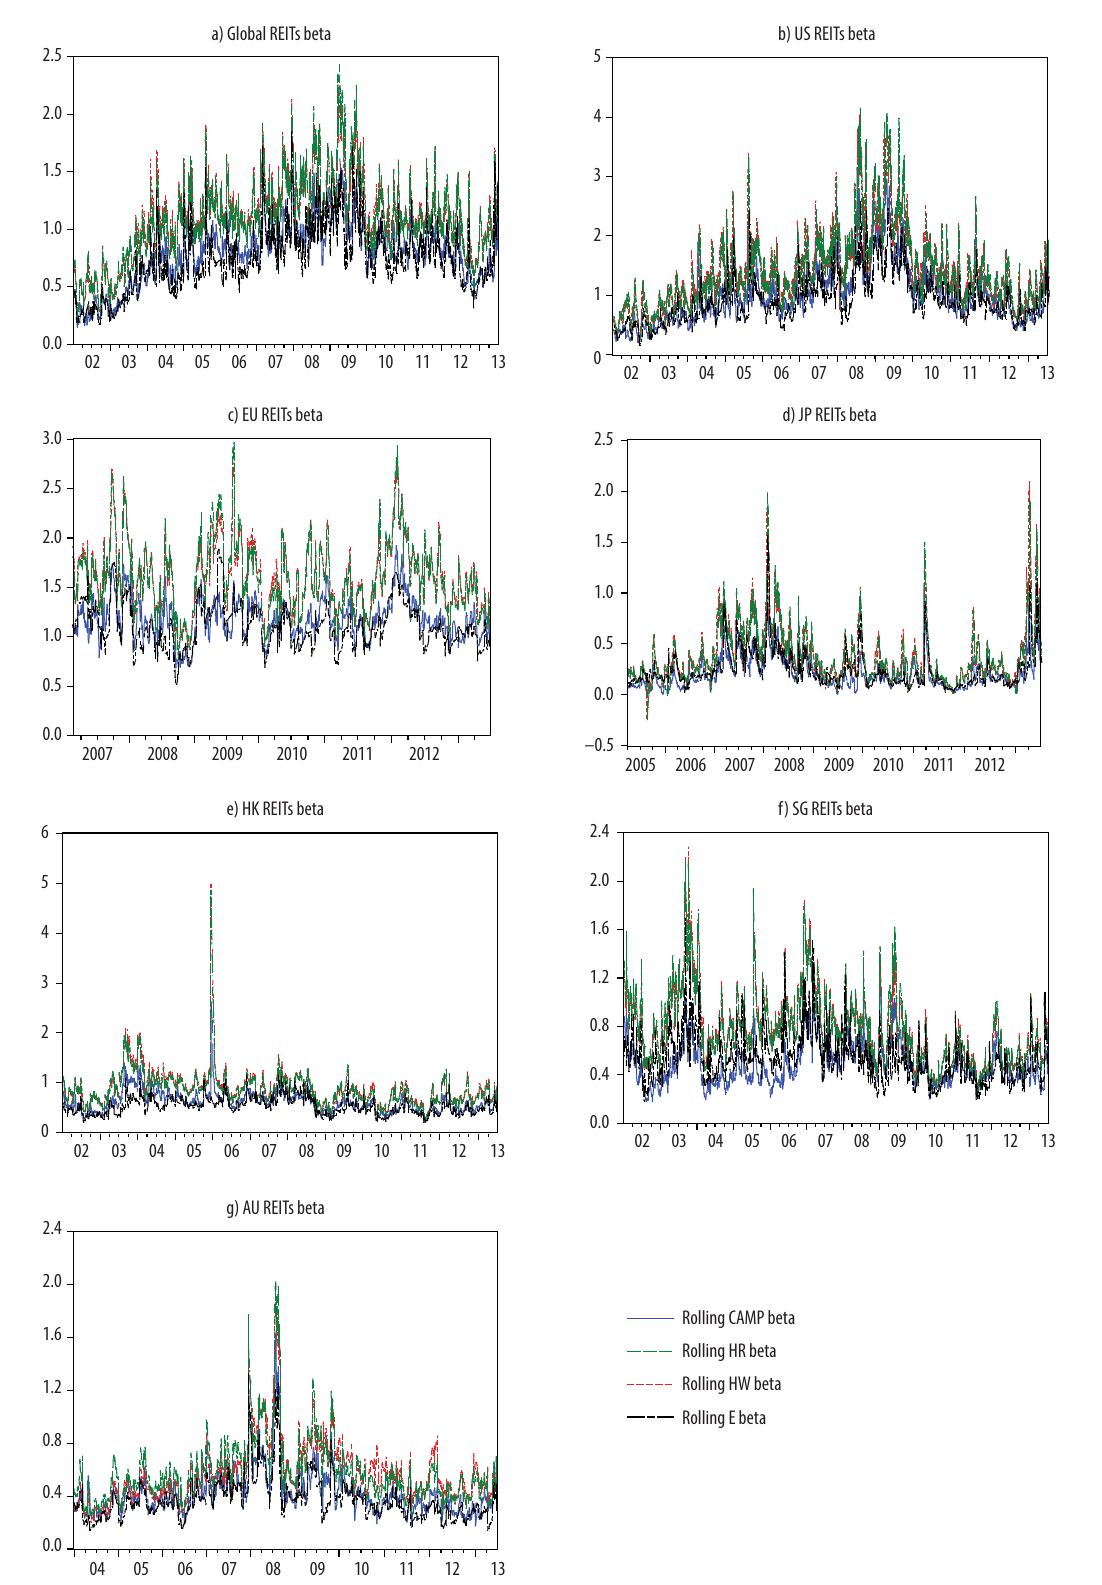
Fig. 4. The time-varying DCC CAPM and DCC downside